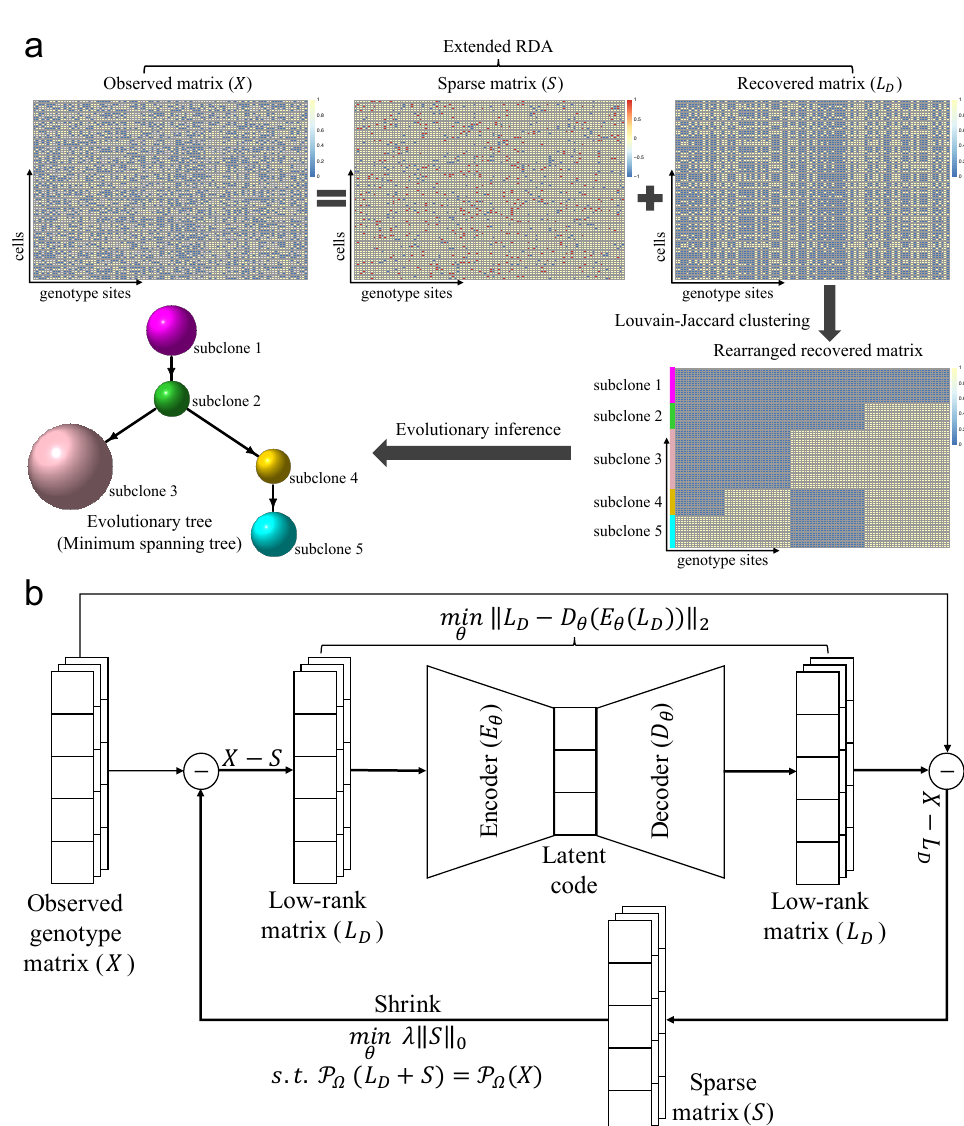
Figure 1. Overview of RDAClone framework and the computational graph for extended RDA model. ( a ) Given the SCGS data with row for cells and column for genotypes as input, RDAClone firstly decomposes the observed matrix (data) into a sparse matrix and a low rank recovered matrix by the extended RDA; clusters cells into subclones based on the recovered matrix by Louvain-Jaccard clustering method; and reconstructs subclone evolutionary tree by the minimum spanning tree of the subclone genotypes. ( b ) Recovering the genotype matrix by our extended RDA model as follows: first, initialize the low-rank matrix L D and sparse matrix S as zero matrices. Then, given an observed matrix X , the low-rank matrix L D calculated by X − S as the input of an encoder to extract the low-dimensional features, reconstructed back to the original dimensional space L D by a decoder, and the sparse matrix S calculated by X − L D is further optimized by a shrink operator to make S sparser. After the convergence of the computation, the recovered matrix L D generated by the extended RDA is kept for the subsequent